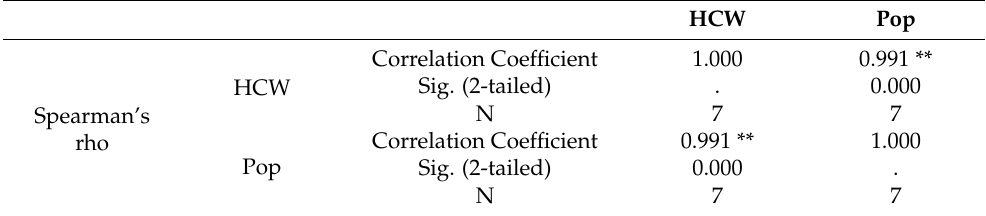
Figure 2. COVID-19 vaccination percentages of PHCC personnel and general population in each health district. Table 5. Correlation between PHCC personnel COVID-19 vaccine acceptance and adult population vaccination coverage against COVID-19.